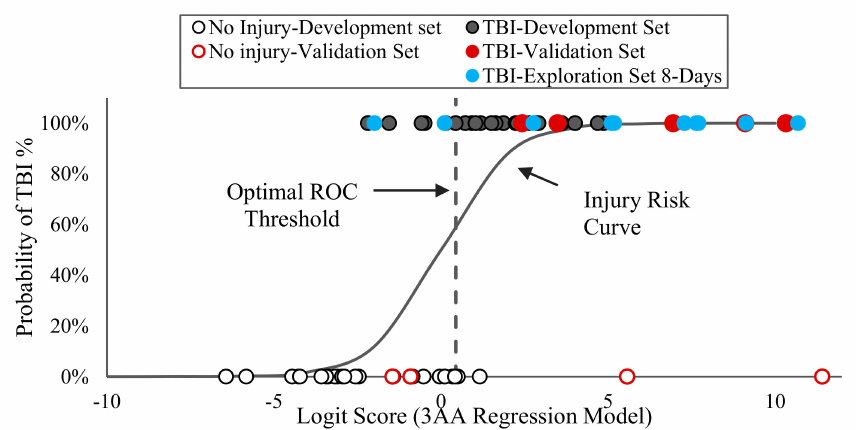
Figure 6. The TBI risk curve based on the optimal multivariate regression biomarker using combination of glycine, taurine, and ornithine serum concentrations and the optimal ROC threshold value (dashed line) of the optimal 3-AA model are shown. The optimal 3-AA regression model was applied and the logit scores for the Development Dataset, Validation Dataset, and Exploration Dataset were calculated.